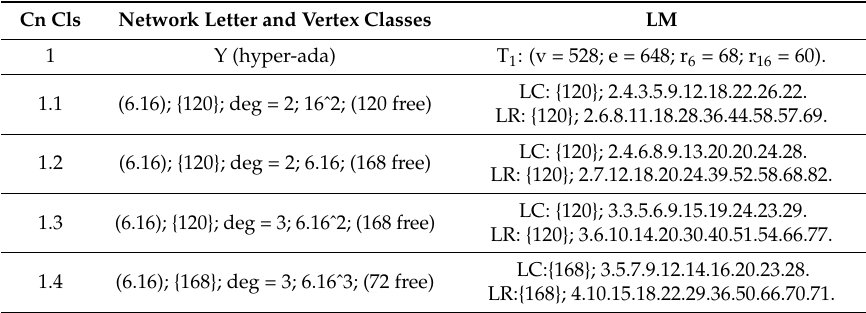
Table A4. Etheric hyper-diamond (no substituents) network: unit/tile; vertex connectivity classes; ring domain; population; degree; point symbol; LM sequence: connectivity (LC) and atom surrounding rings